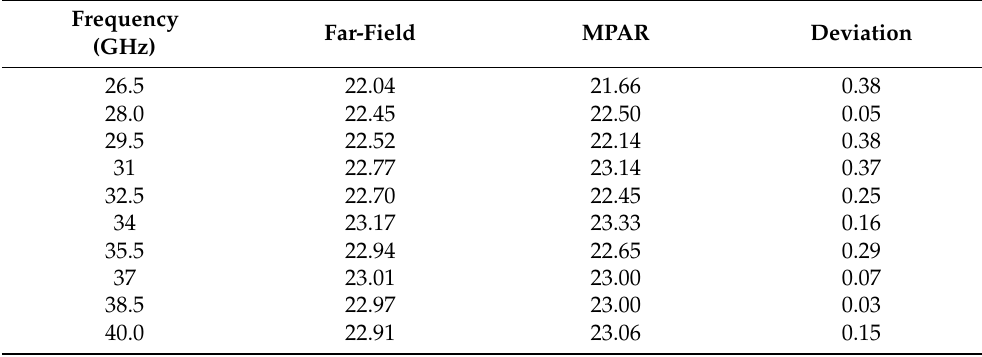
Table 3. Fixed-frequency power gain of standard horn